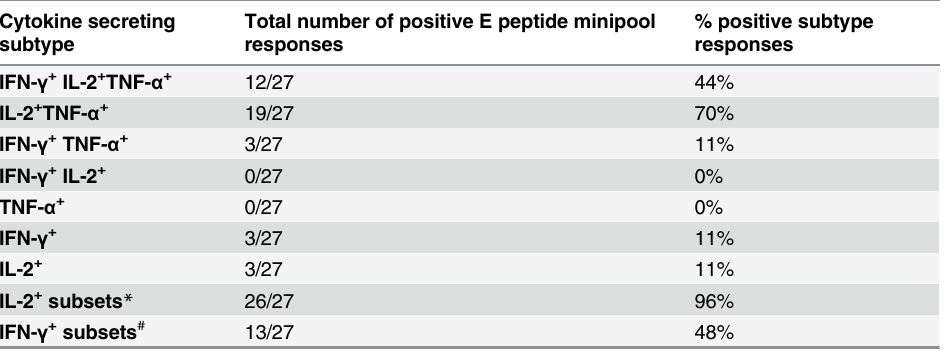
Table 1. Analysis of Th1 subtype responses to E peptide minipools in 11 TBE-vaccinated subjects.